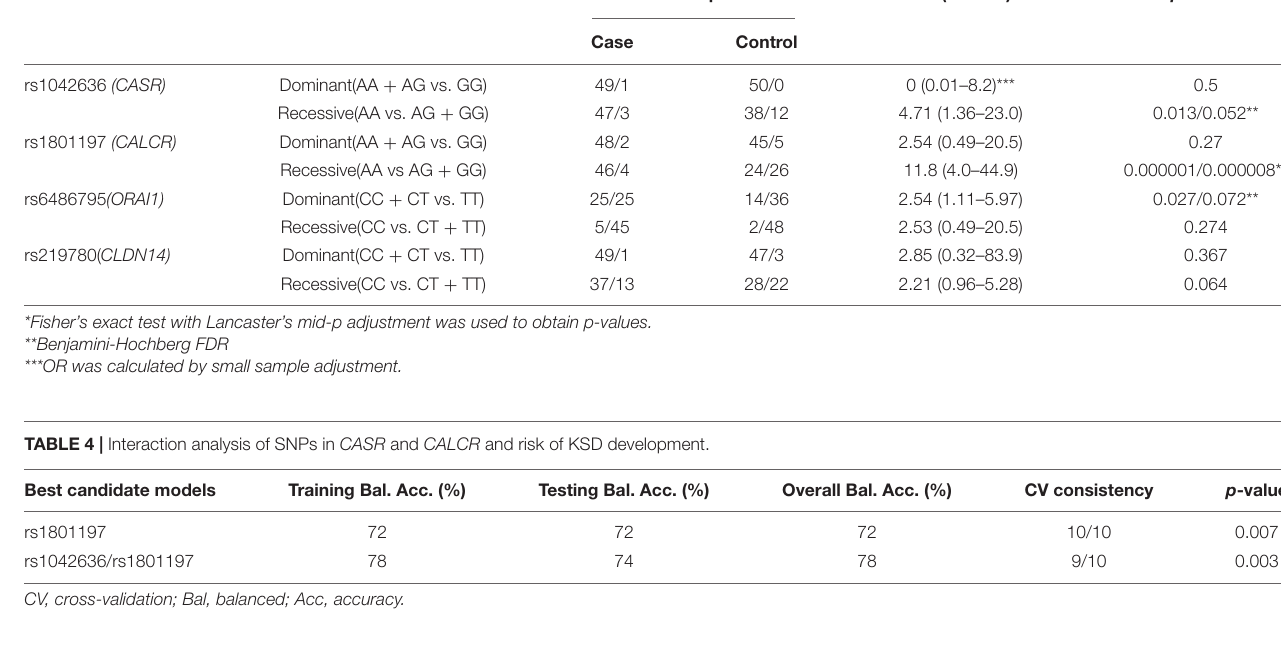
TABLE 3 | Association of the CASR , CALCR , ORAI1 , and CLDN14 genes genotypes with the risk of calcium urolithiasis development under the different inheriting models. Locus